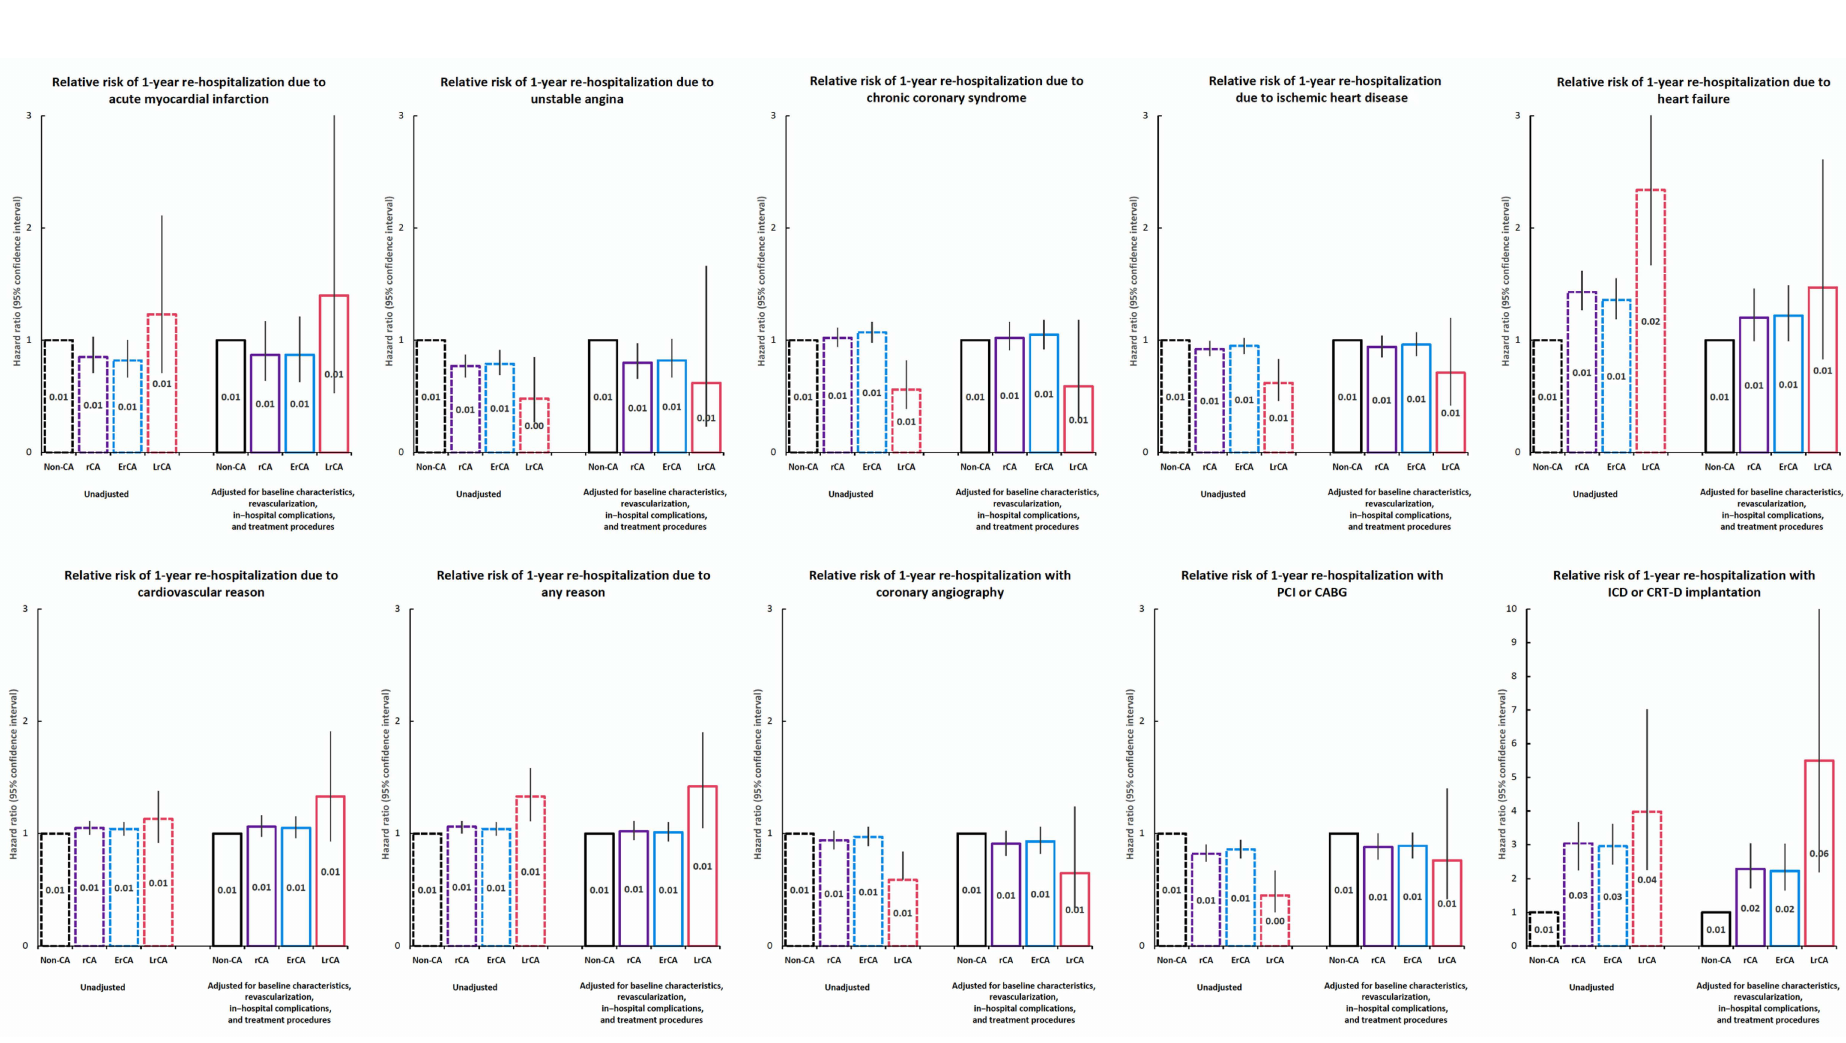
Figure 2. Relative risk of 1-year